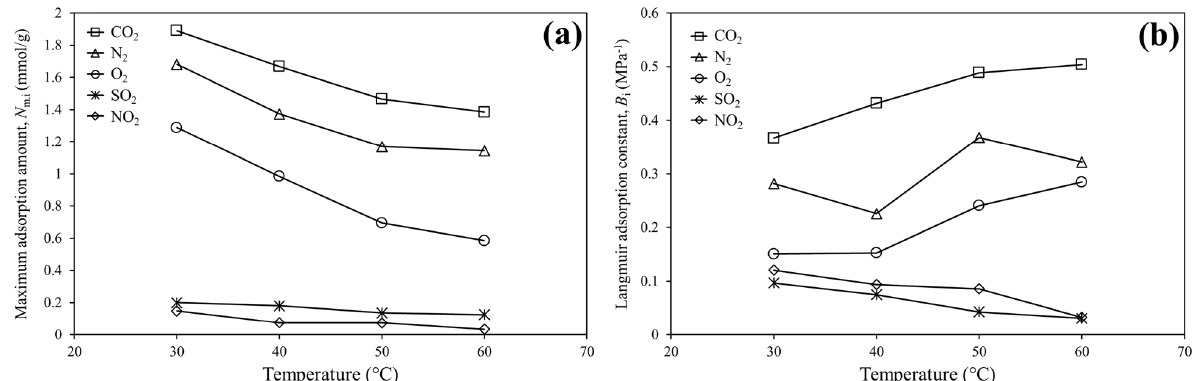
Fig. 10 Change curves of extended Langmuir parameters with temperature: a Maximum adsorption amount; b Langmuir adsorption constant for Coal EML